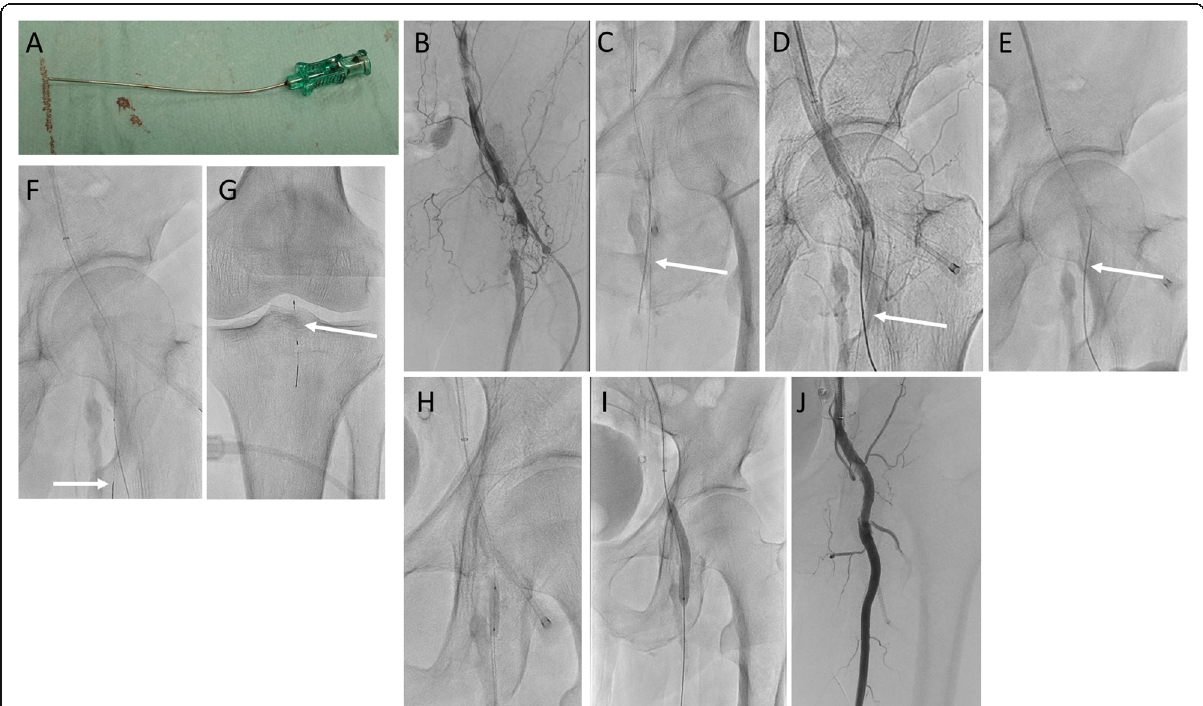
Fig. 4 a Image showing a 21-G needle that is slightly curved. b Calcified plaque in the left CFA. c, d The needle was advanced into the center of the calcified plaque while observing from multiple directions with a fluoroscopic guide. e The needle on the externalized guidewire is coaxially placed in and out several times to puncture the lesion. f An antegrade wire was advanced into the SFA. g We placed the filter wire in the popliteal artery. h, i We dilated the CFA with a scoring balloon and high-pressure balloons. j Final angiography shows that the CFA